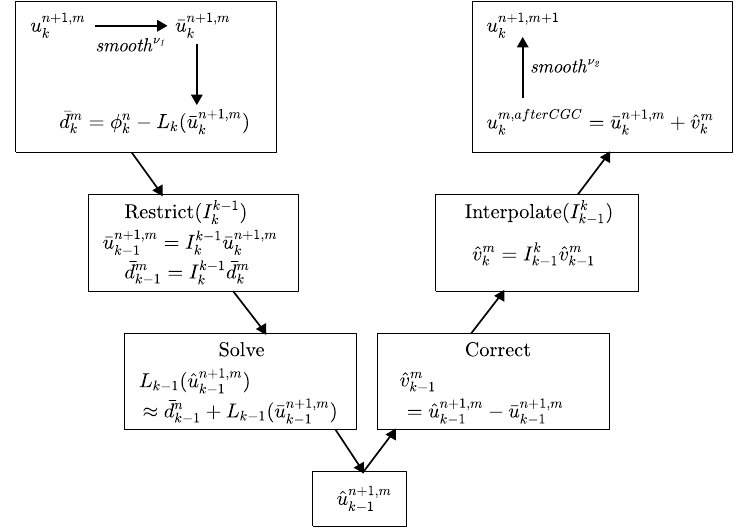
Figure 3. Multigrid two-grid V-cycle method.